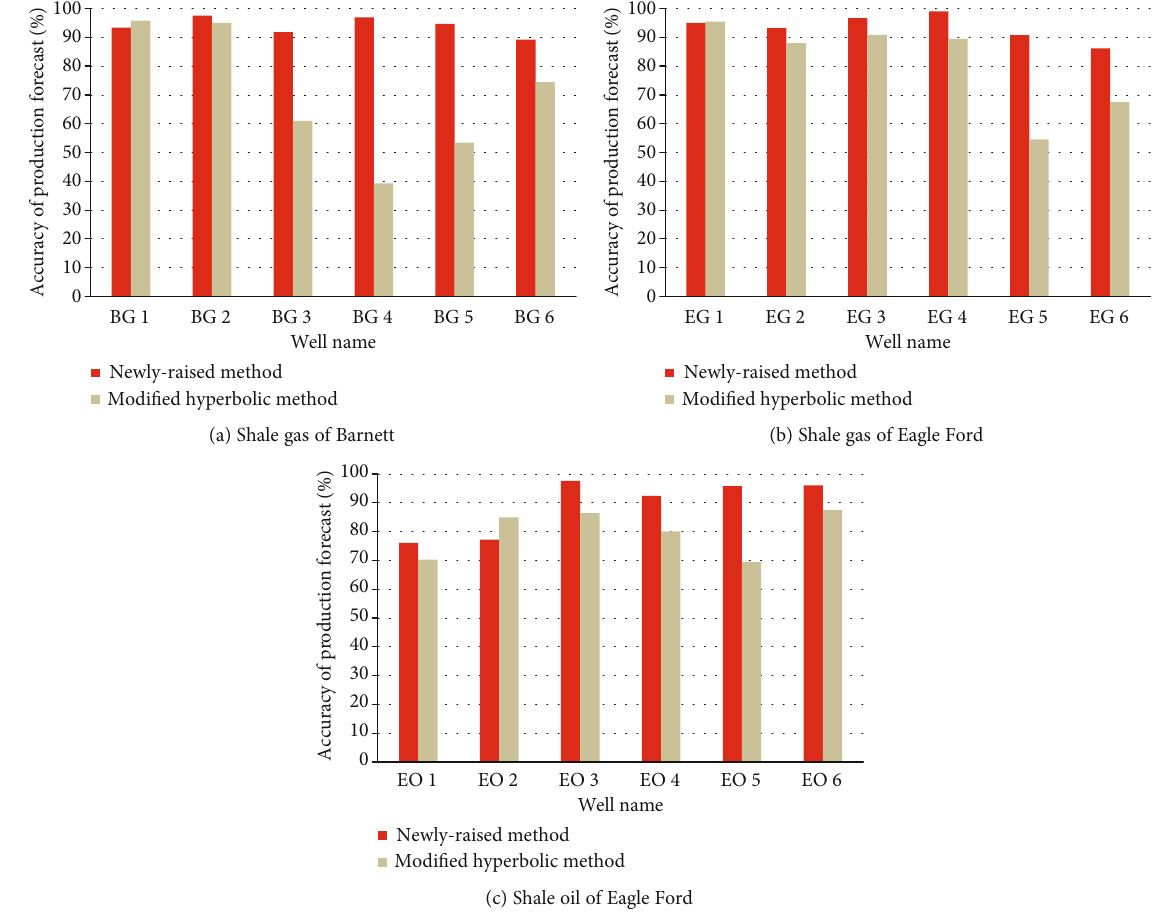
Figure 5: Forecast accuracy comparison of two methods.